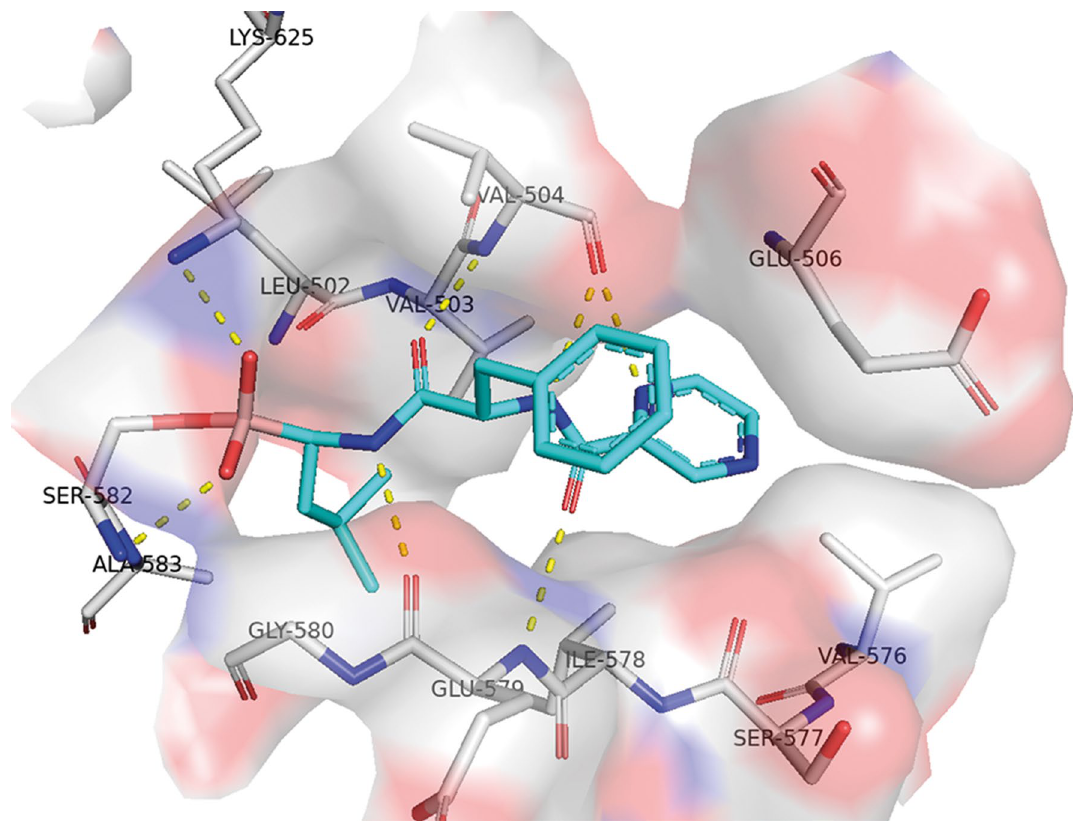
Figure 6. Active site region of the LonC serine protease (PDB entry code 4FWD) with covalently bound Bortezomib to active site serine 582. The pyrazine and leucine moieties are completely buried in the hydrophobic groove in the corresponding S1 and S3 pockets and stabilized by a hydrogen bonding